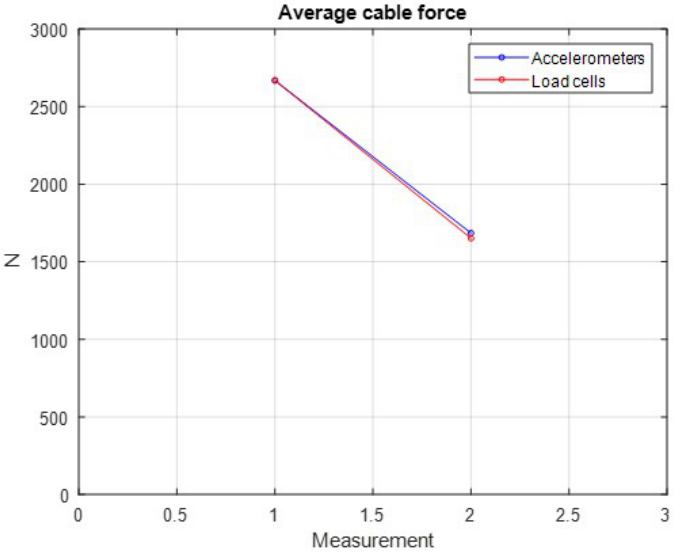
Figure 28. Average cable forces after manual interventions in the tensioners of Cables 1 and 3. In this case, no faults were reported, remembering that the minimum average force to indicate a failure was defined as 1500 N and the position of the top center of the tower presents practically no displacements measured by the inclinometer (red dot). Graphically, the indication of the current status of the tower is shown in Figure